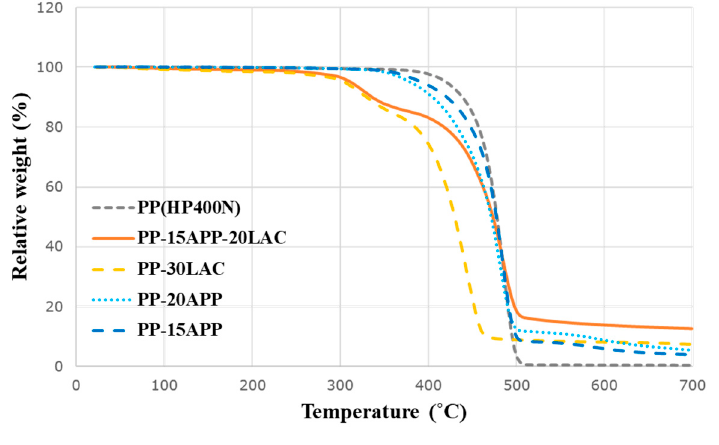
Figure 5. ( a ) Thermogravimetric and ( b ) derivative thermogravimetric curves of neat PP, PP–LAC, Figure 5. Cont and PP–LAC–APP samples in nitrogen.